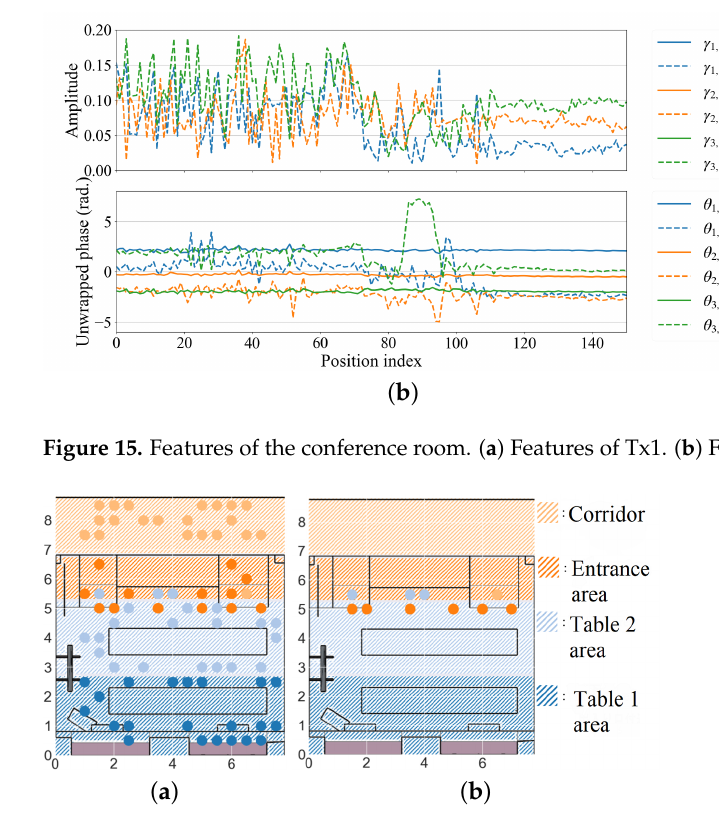
Figure 16. Classification result. ( a ) Classified position. ( b ) Misclassified